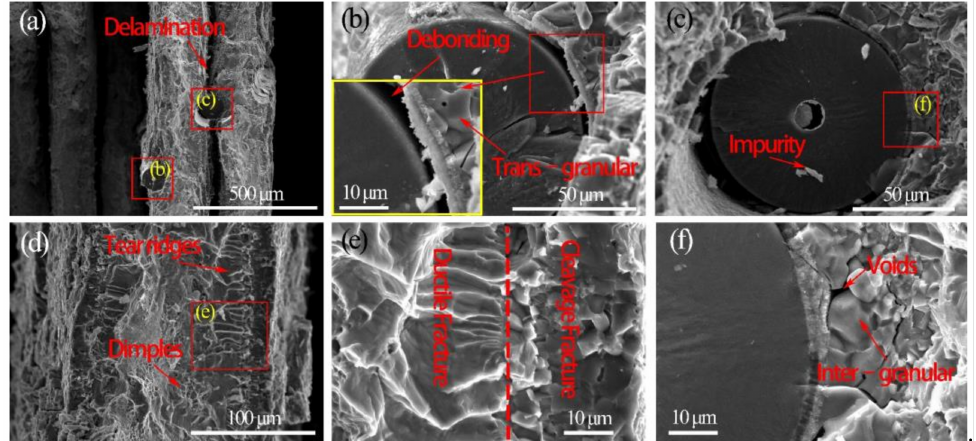
Figure 15. The tensile fracture surfaces of SiC f -reinforced Ti/Ti–Al laminated composite: ( a ) Delami- nation in the Ti–Al intermetallic layer, ( b ) Debonding between fracture SiC fiber and the intermetallic matrix, ( c ) Interface between SiC fiber and the intermetallic matrix, ( d ) Dimples and Tear ridges in the Ti layer, ( e ) Interface between Ductile Fracture and Brittle Fracture, ( f ) Inter–granular in the Ti–Al intermetallic